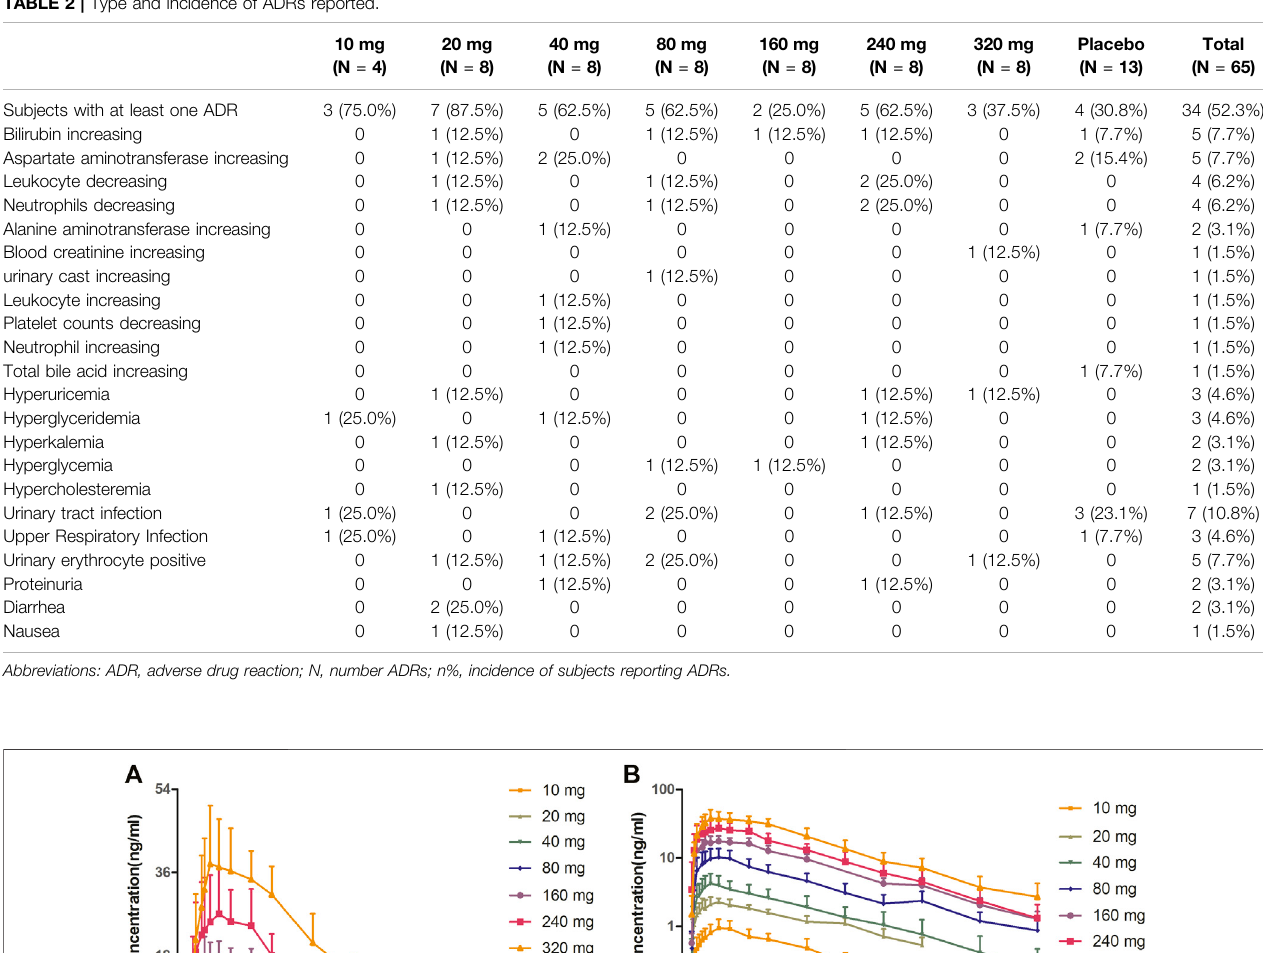
TABLE 3 | Mean (SD) pharmacokinetic parameters for QX002N in healthy subjects after single ascending dosing of QX002N injection. Parameter